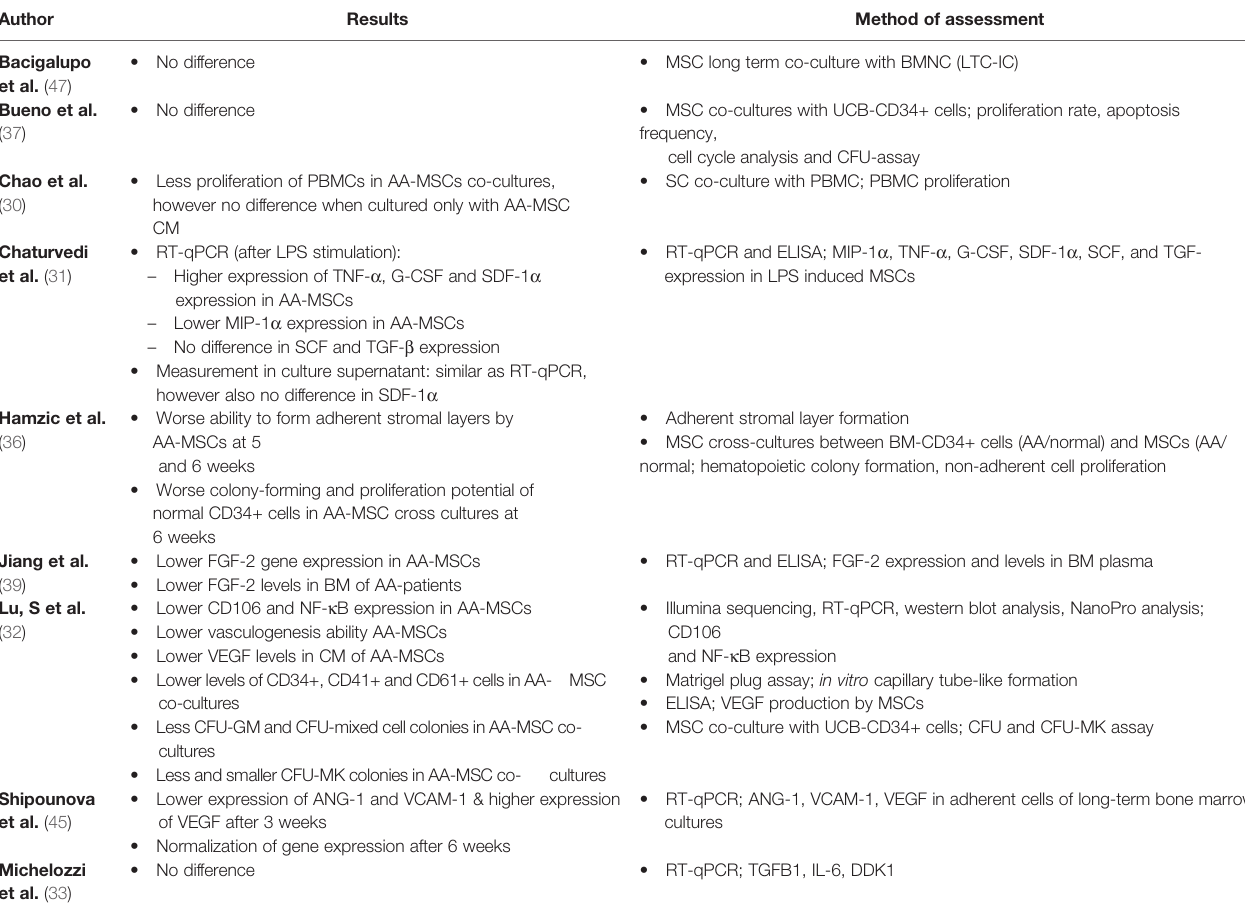
TABLE 9 | Assessment of hematopoietic supporting activity.